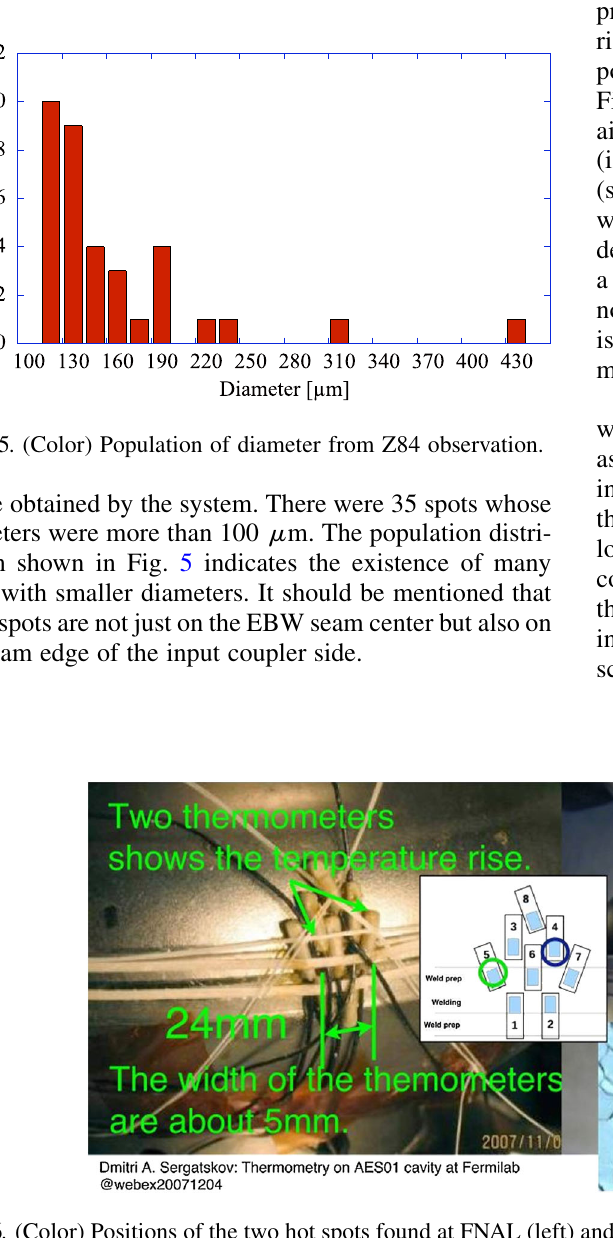
FIG. 4. (Color) Typical image of Z84. Many cat’s-eye-shaped spots were